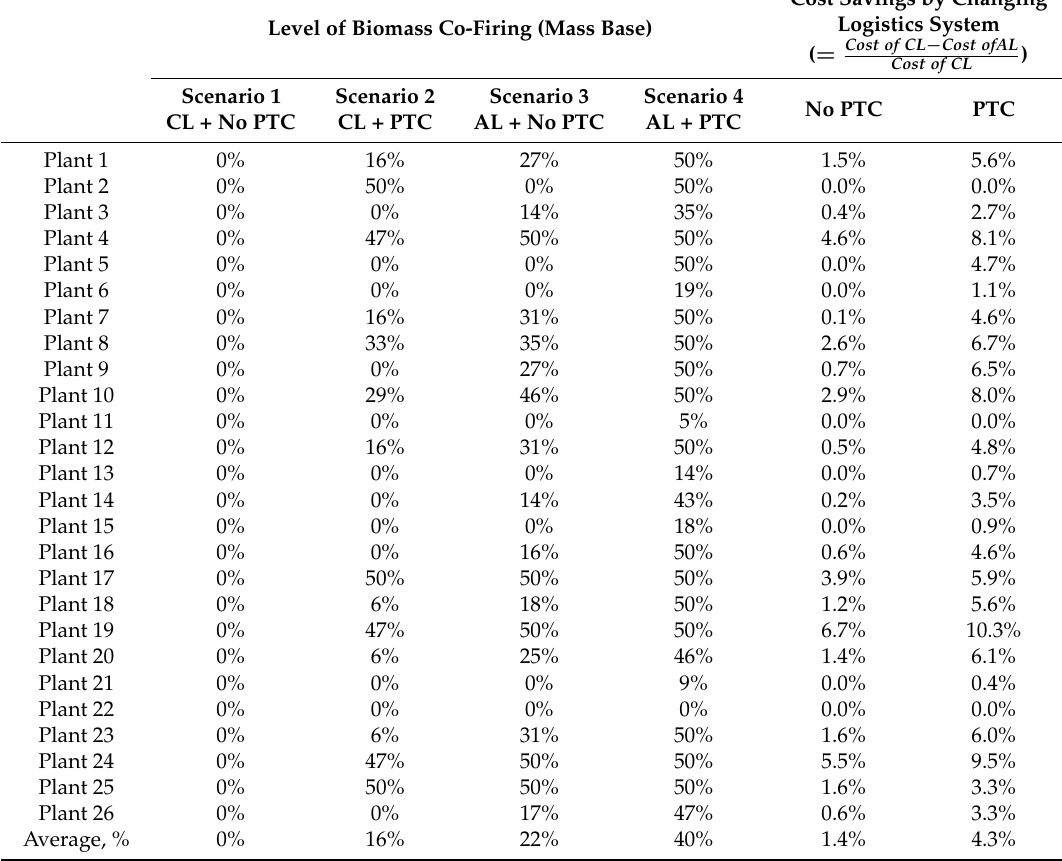
Table A3. Individual plant results of biomass co-firing ratios and cost savings by advanced logistics